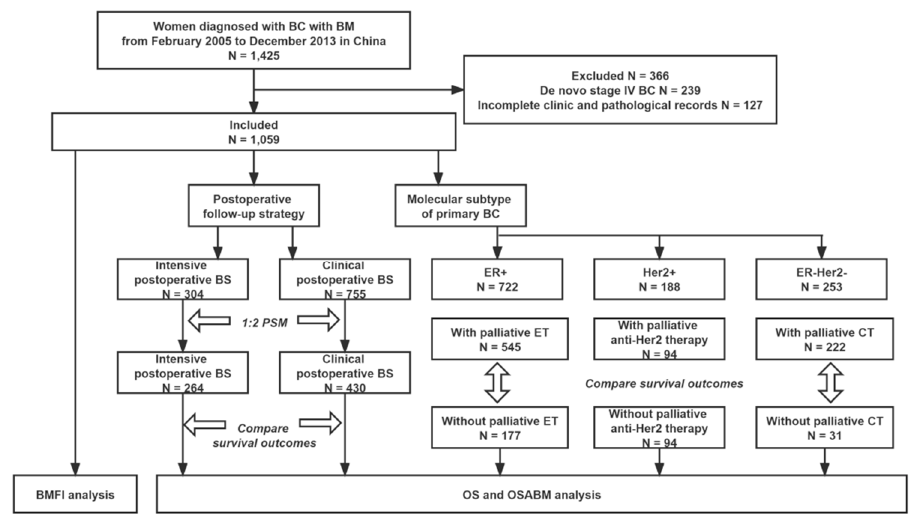
Figure 1. Flowchart of the process of patient’s enrollment and analyses. Abbreviations: BC = breast cancer; BM = bone metastasis; BMFI = bone metastasis-free interval; BS = bone scan; CT = chemo- therapy; ER = estrogen receptor; Her2 = Human epidermal growth factor receptor 2; ET = endocrine therapy; OS = overall survival; OSABM = overall survival after diagnosis of bone metastasis; PSM =